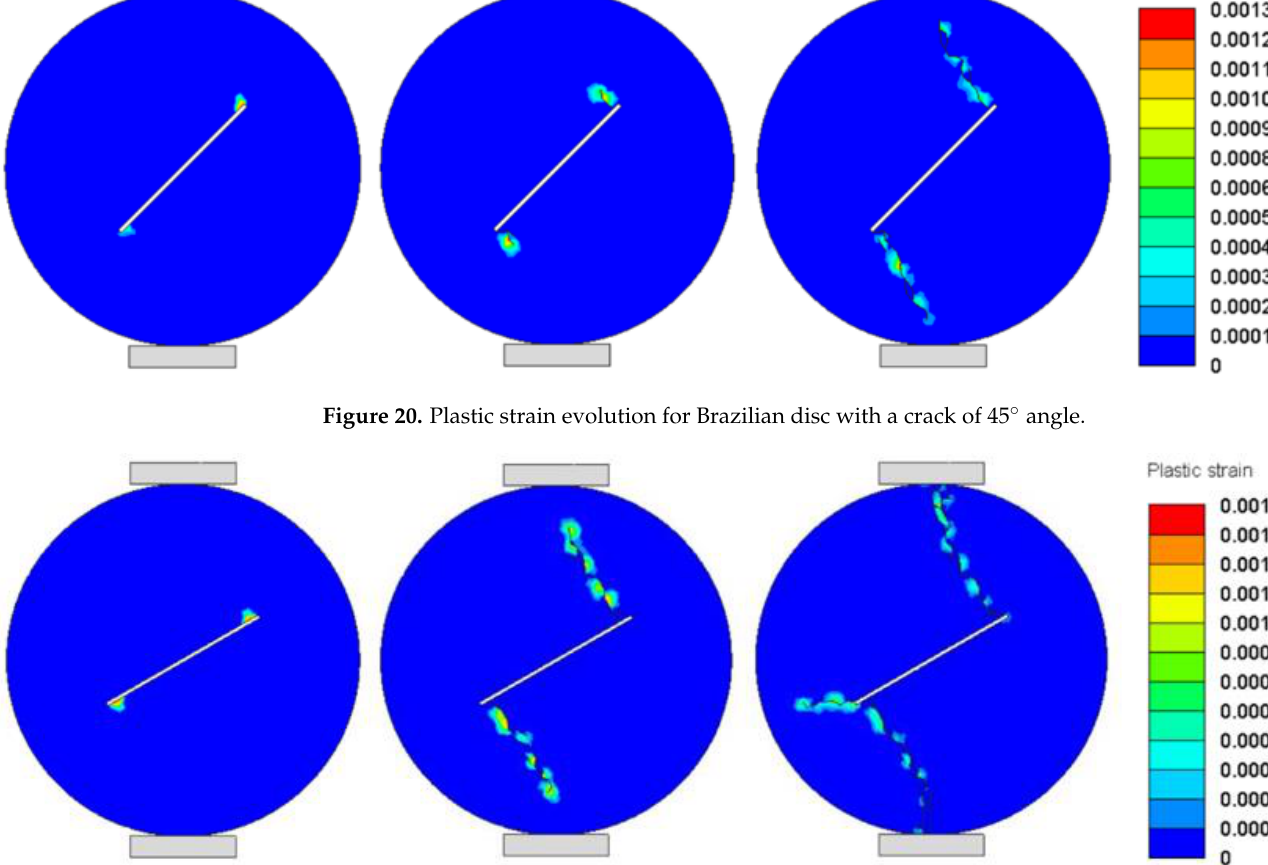
Figure 21. Plastic strain evolution for Brazilian disc with a crack of 60° angle.